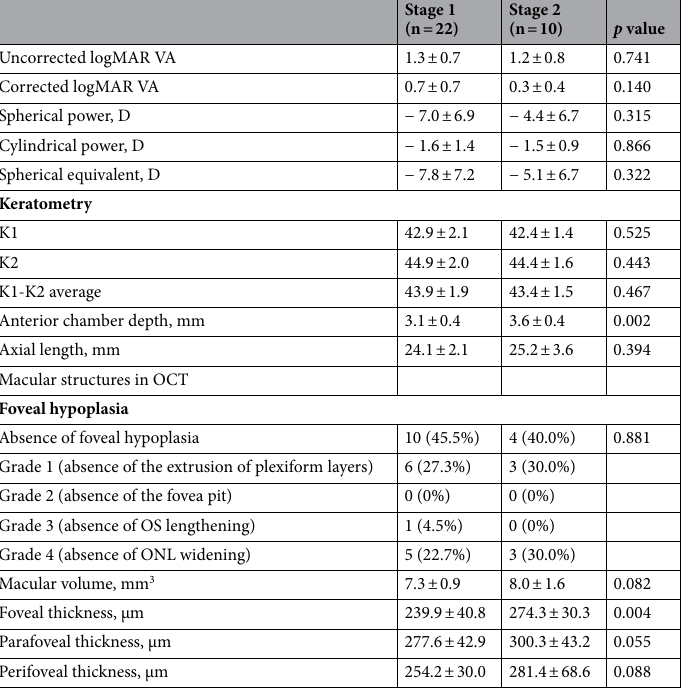
Table 5. Parameters of eyes with familial exudative vitreoretinopathy. VA: visual acuity; D: diopters; OCT: optical coherence tomography; OS: outer segment; ONL: outer nuclear